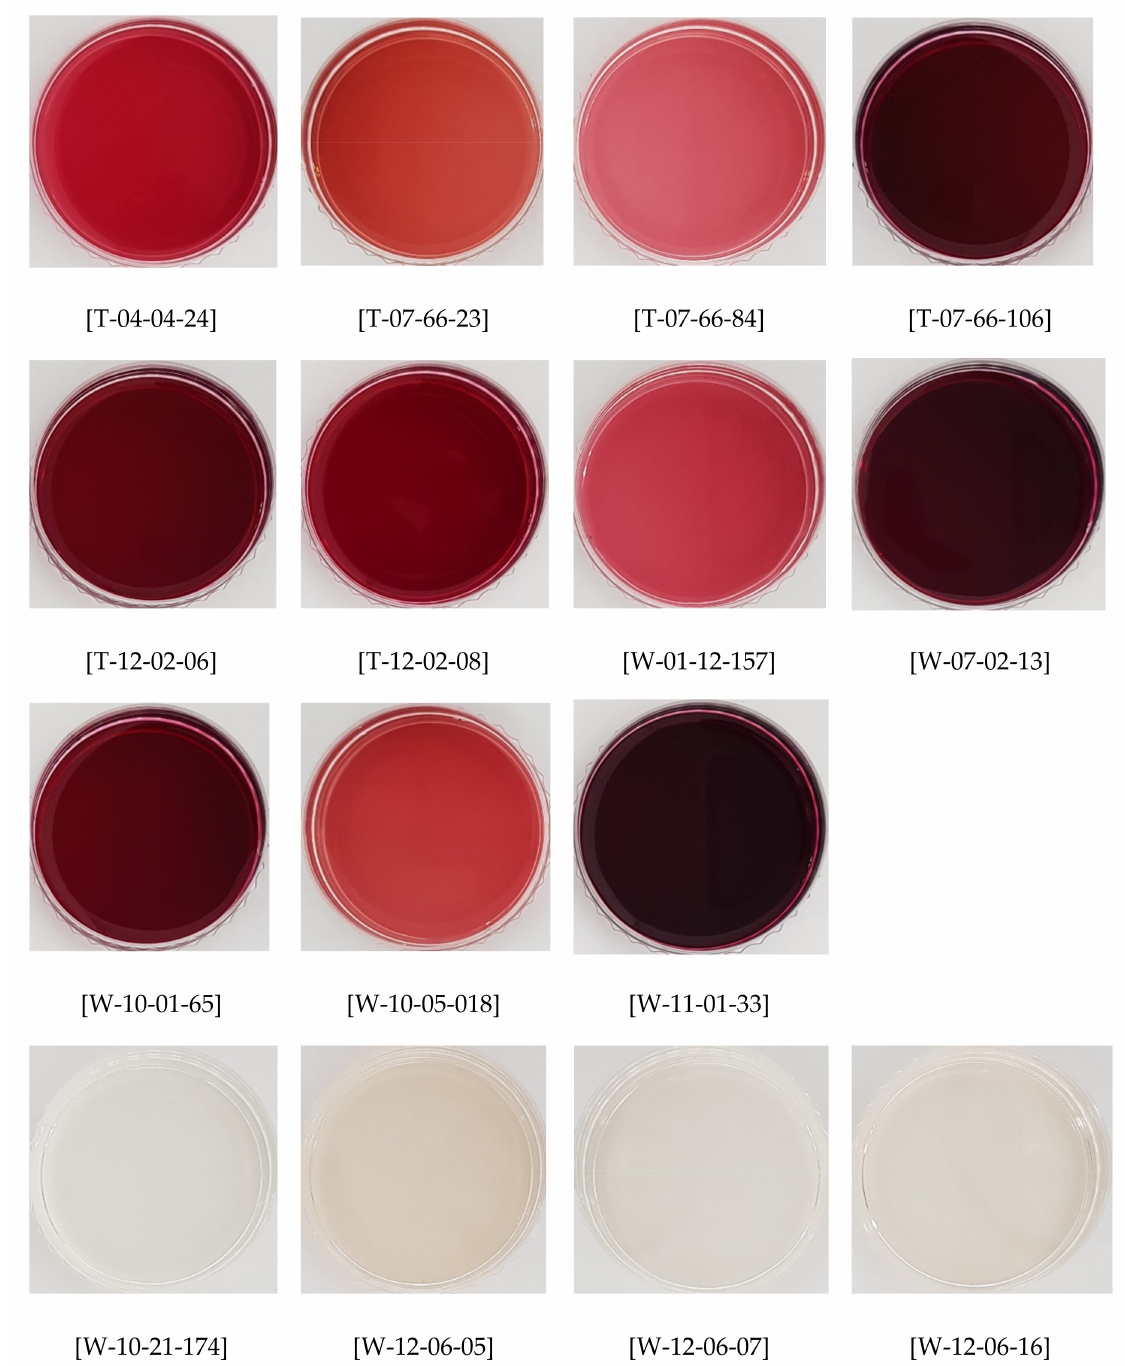
Figure 1. Visual appearances of wines made from di ff erent breeding